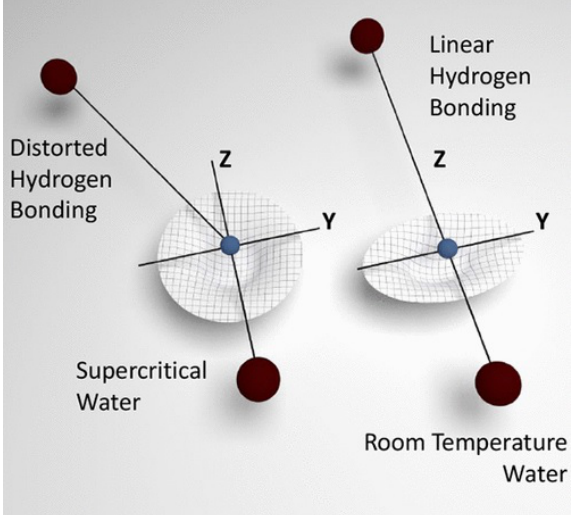
Figure 13. Pictorial representation of the local H-bond geometry for H 2 O at supercritical ( left ) and ambient conditions ( right ). The figure depicts the coordinate frames used in the interpretation of NCS data, and the corresponding (partially isotropic and anisotropic) proton momentum distributions. Reprinted with permission from Ref. [332]. Copyright (2021) American Chemical